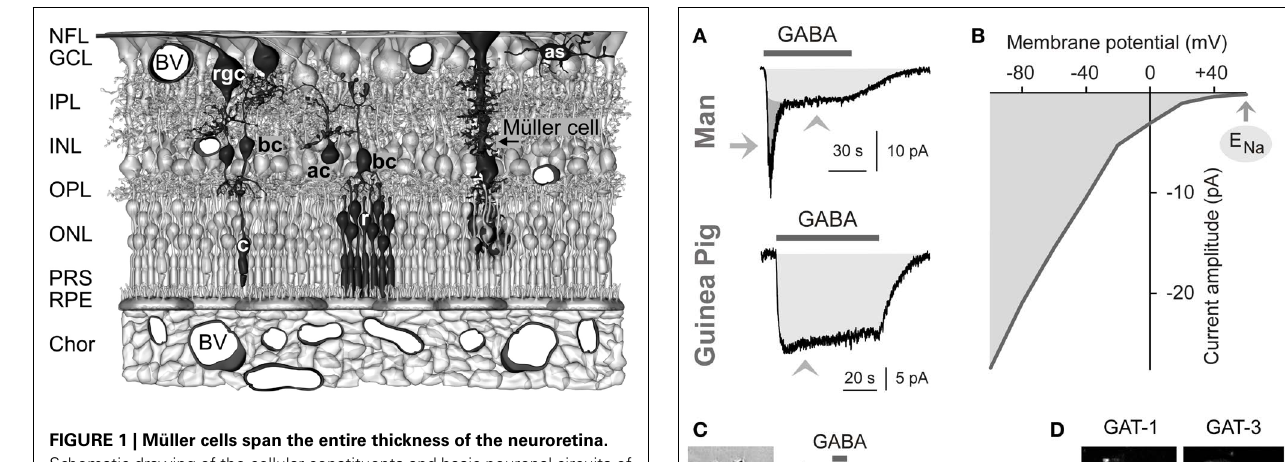
species. Müller cells of the guinea pig express GAT-1 and